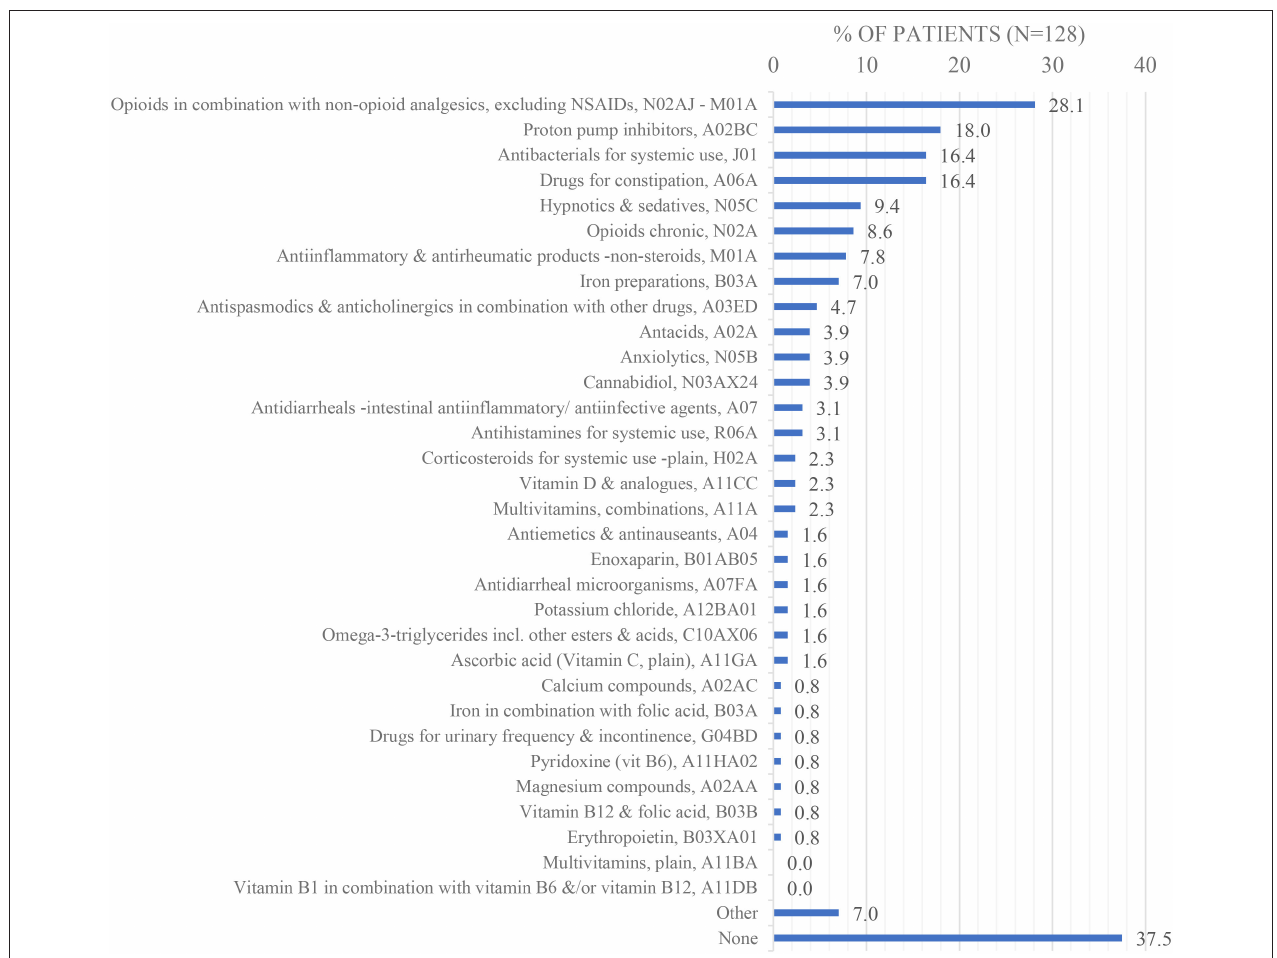
FIGURE 5 | Acute preoperative